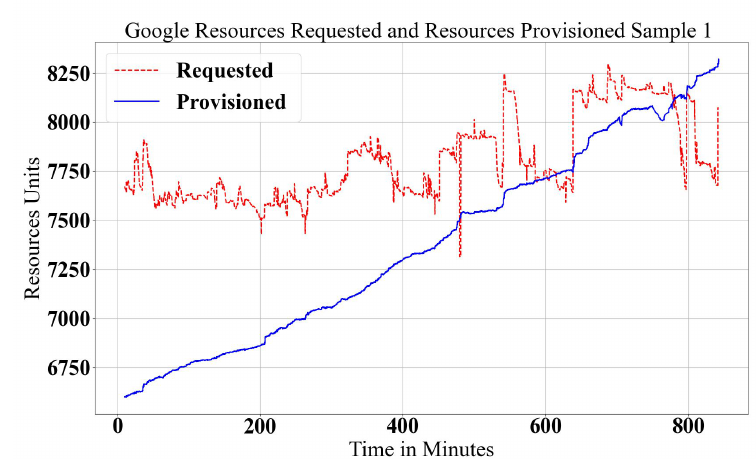
Figure 2. Google data center Provisioned and Requested Workloads, Sample 1.